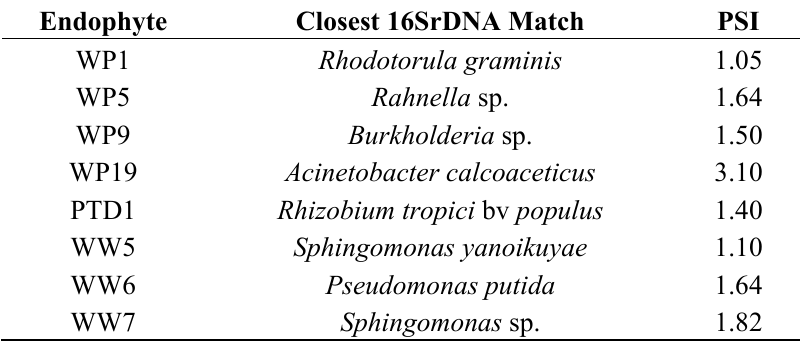
Table 1. Poplar and willow endophytes used in this study and their phosphate solubilization index (PSI) in the plate assay